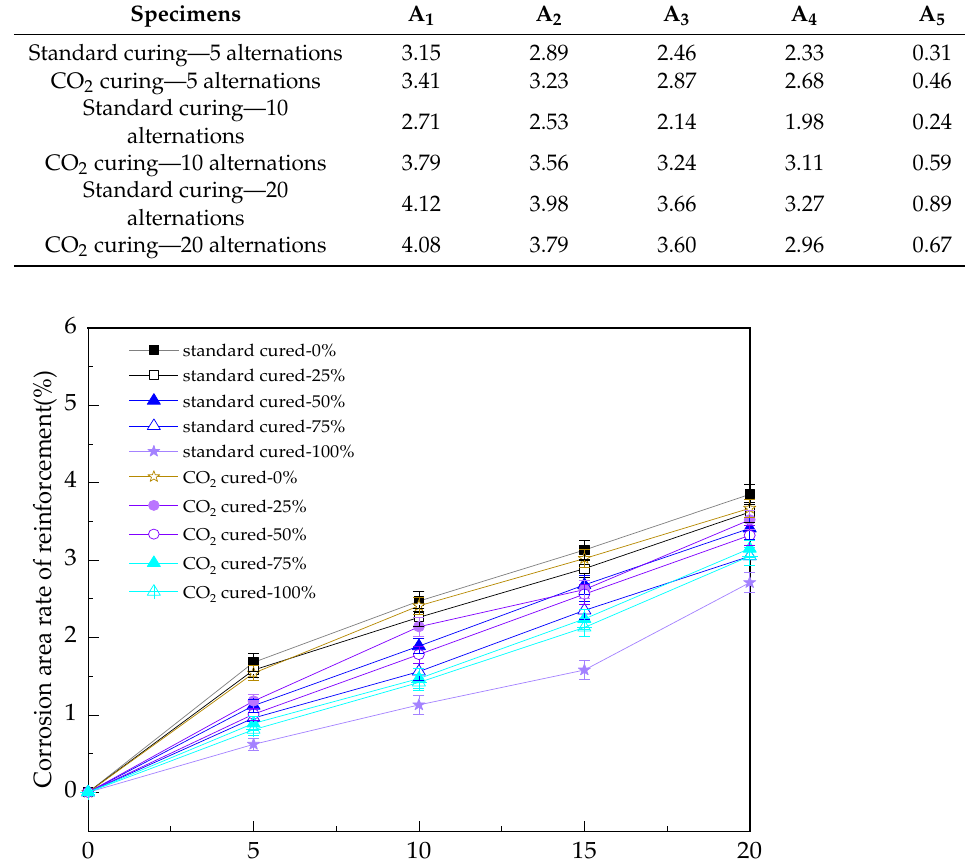
Figure 8. The corrosion rate of inner steel bars during D–W alternations. Table 4. The corrosion current of reinforced alkali-activated mineral admixtures(10 − 6 A/cm 2 ). Specimens